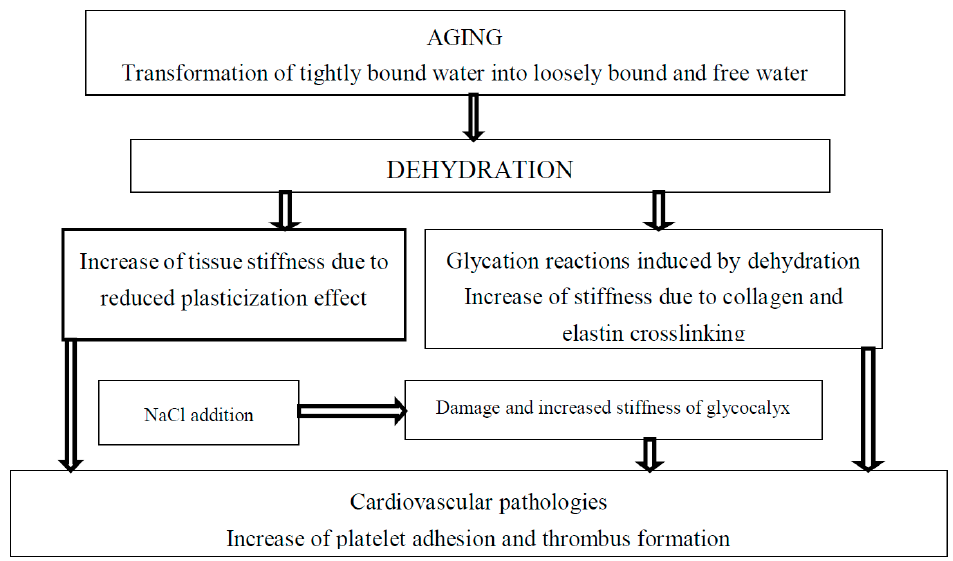
Figure 1. The effect of tightly bound water transformations on tissue stiffness and related Figure 1. The e ff ect of tightly bound water transformations on tissue sti ff ness and related cardiovascular diseases. cardiovascular